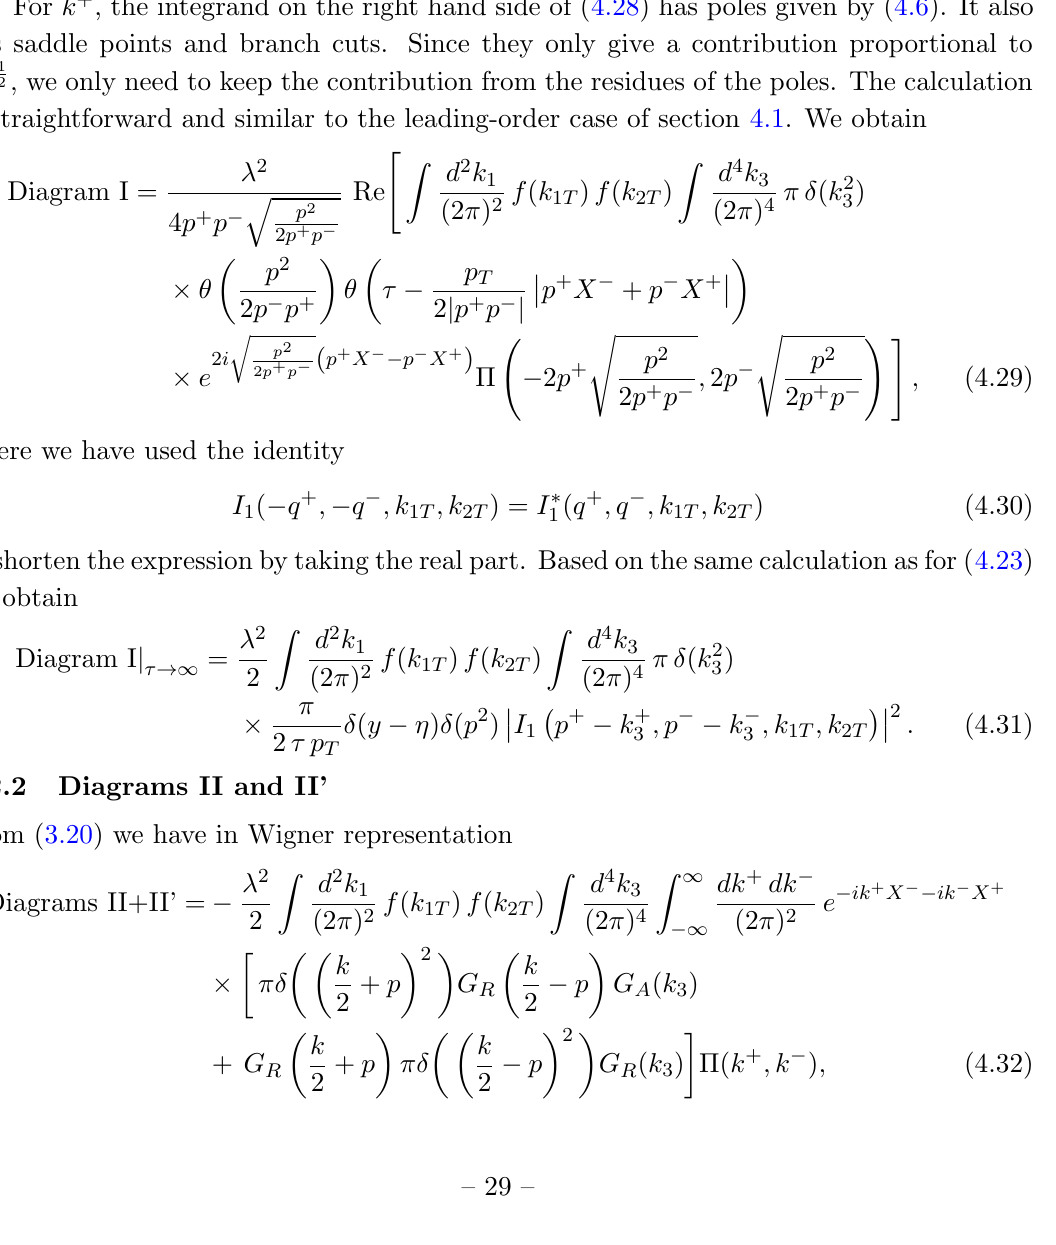
Figure 9 . Relative positions of poles with respect to the steepest descent path. Here, we assume that p + > 0 and that the two poles are located at k + = (cid:6) 2 p + the possible cases when one needs to keep the residues of the poles in the k + integration in (4.33). For k + , the integrand on the right hand side of (4.28) has poles given by (4.6). It